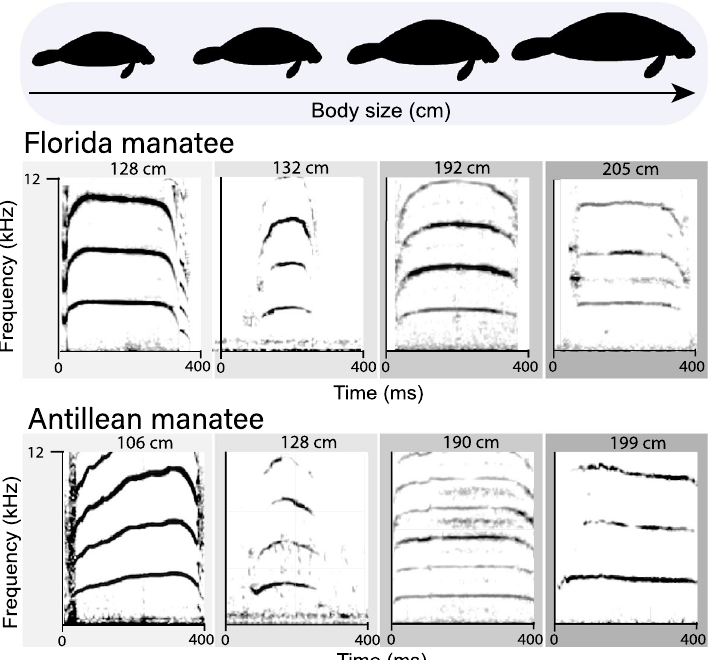
Figure 4. Ontogenetic changes from a hill-shape to a linear call contour of the vocalizations of the Florida manatee ( T. m. latirostris ) and the Antillean manatee ( T. m. manatus ). The Florida and Antillean manatee are subspecies of the West Indian manatee ( Trichechus manatus